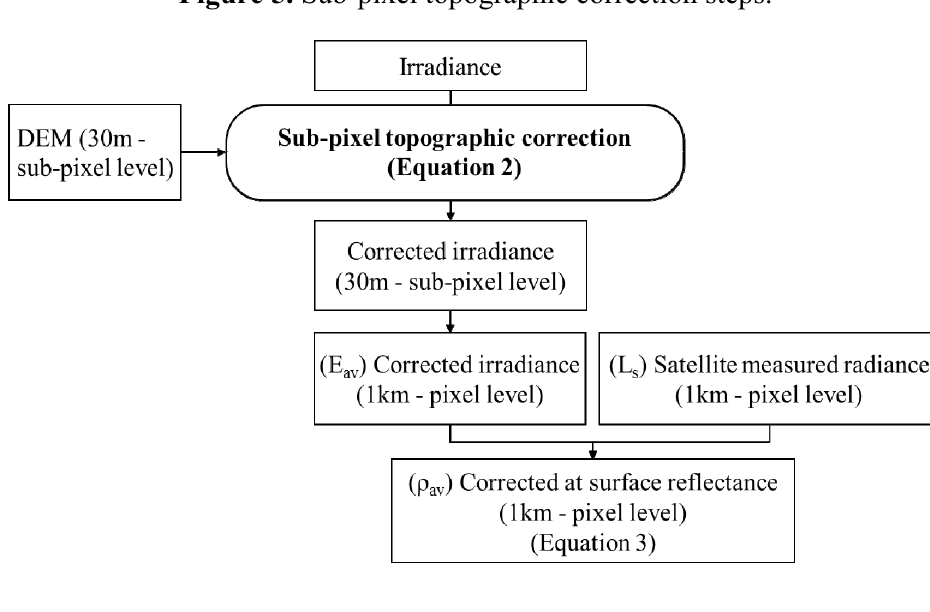
Figure 5. Sub-pixel topographic correction